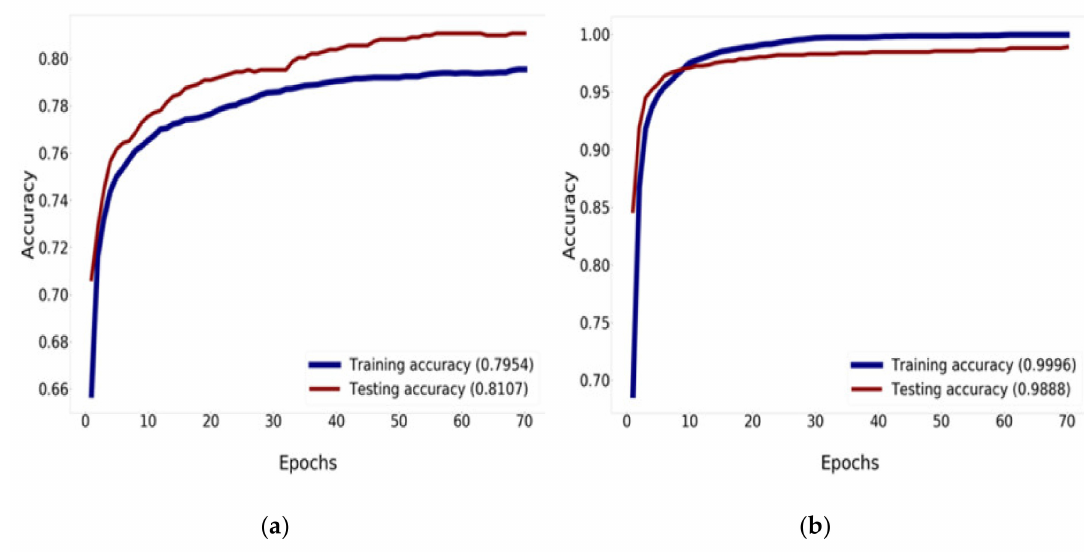
Figure 12. Training and validation accuracy history: ( a ) training and validation accuracy of DenseNet-121; ( b ) training and validation accuracy of DenseNet-121 combined with Mish and Nadam.